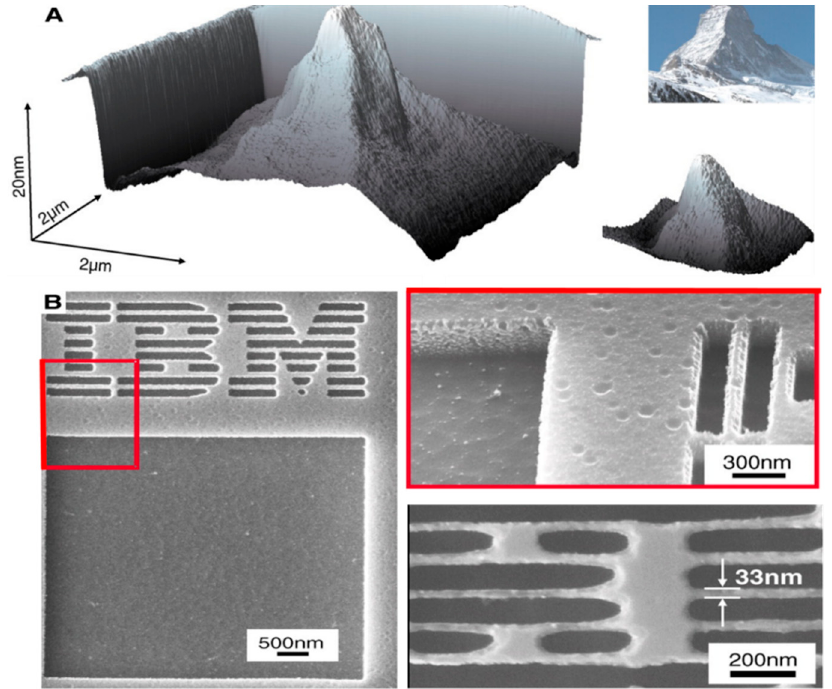
Figure 15. 3D structures fabricated by thermal tip: ( A ) 3D sculpture of the Matterhorn. ( B ) 3D image of the IBM letters [94] .